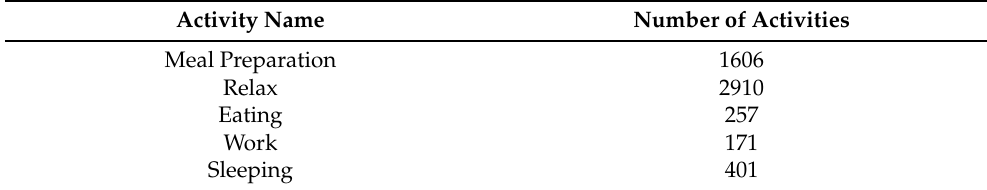
Figure 9. Sampled detection motions. Table 1 summarizes the labeled activities in Aruba dataset. Table 1. Annotated activities in Aruba